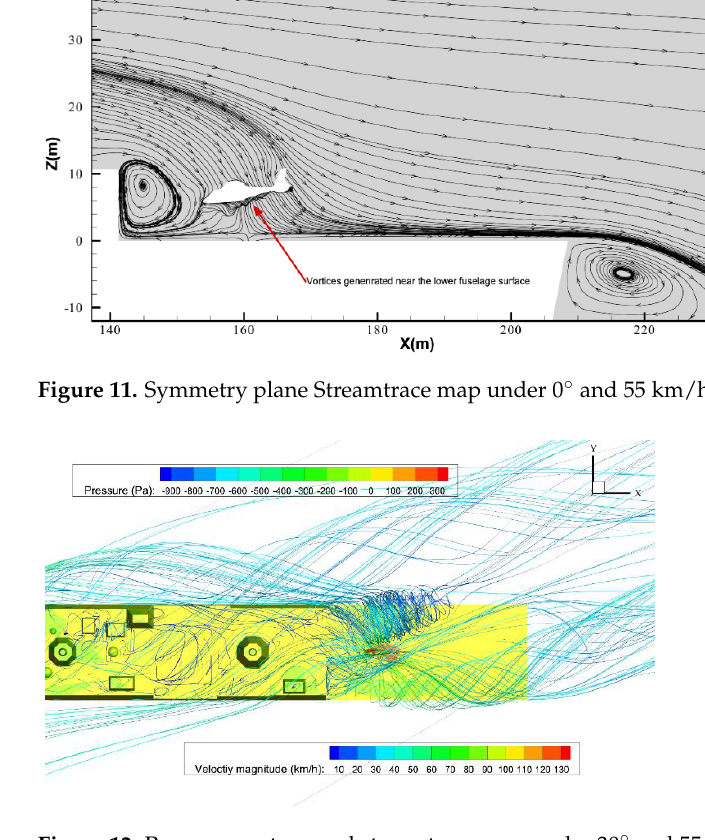
Figure 12. Pressure contour and streamtrace map under 30° and 55 km/h WOD condition.